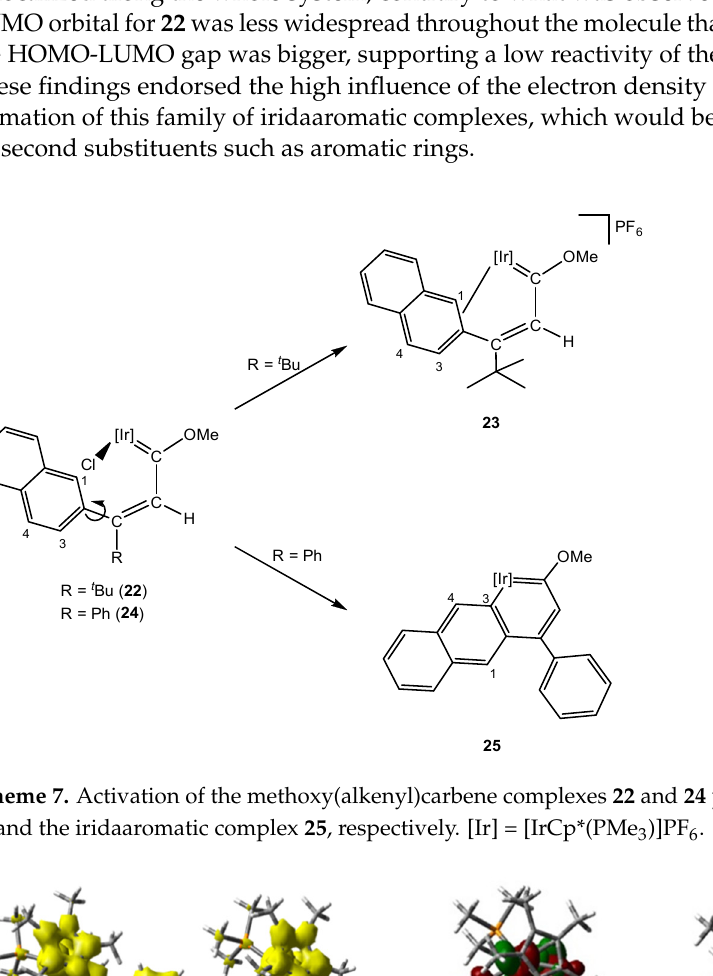
Figure 1. ACID representations (left) and LUMO orbitals (right) of complexes 22 and 24 .